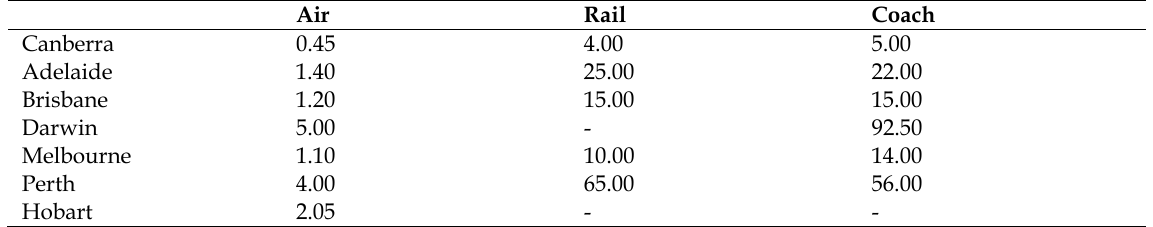
Table 1. Vehicle Travel Times (hours) from Sydney to Other Major Cities in Australia Air Rail Coach